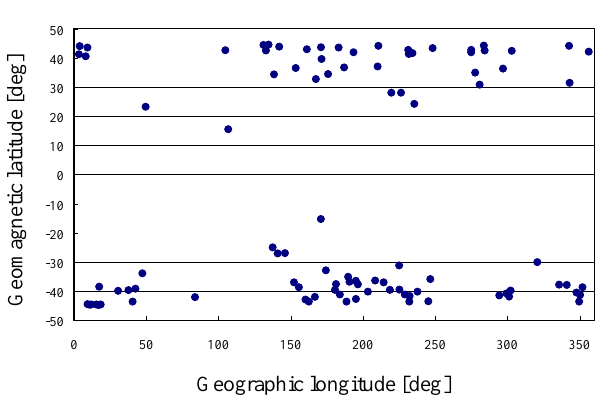
Fig. 5. Latitude-longitude distribution of the ELF electric field bursts